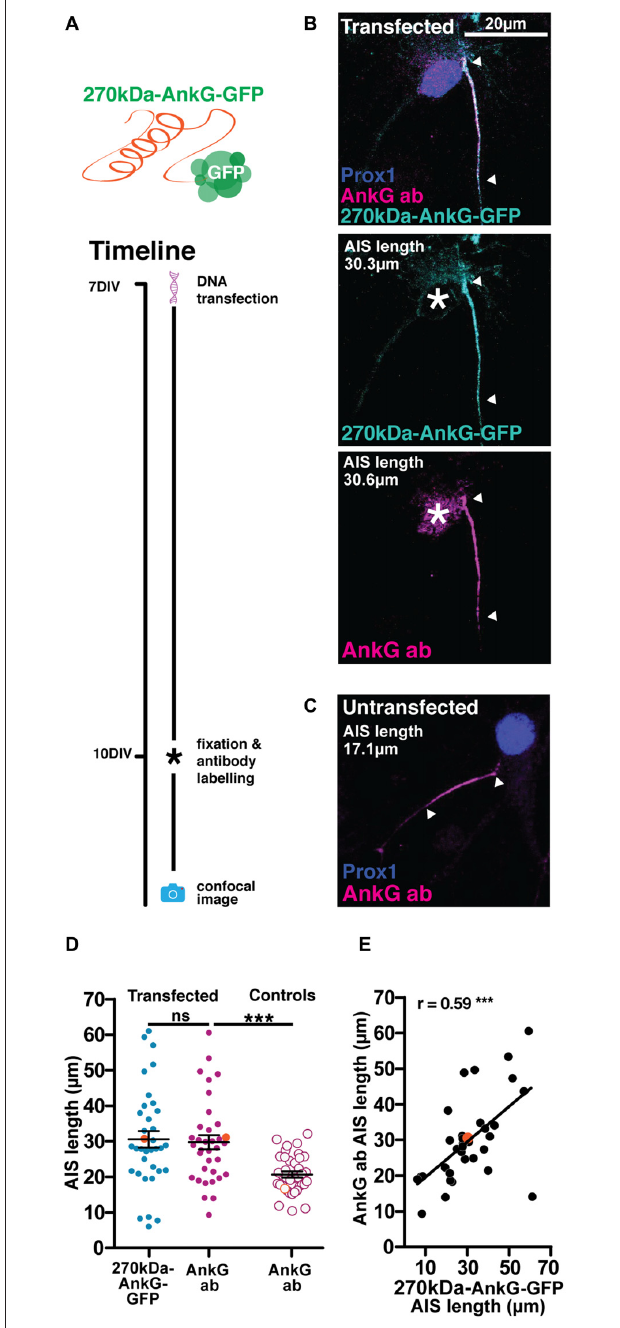
FIGURE 6 | The 270kDa-AnkG-GFP construct artificially increases AIS length in mature neurons. (A) Diagram of construct used and transfection method timeline. (B) Maximum intensity projection of a DGC expressing 270kDa-AnkG-GFP (cyan) which co-localizes with an anti-AnkG antibody (magenta). Asterisks, nucleus; arrowheads, DGC AIS start and end positions. (C) Maximum intensity projection of an untransfected DGC bearing an AIS of normal length. Arrowheads DGC AIS start and end positions. (D) Distributions of AIS lengths measured from 270kDa-AnkG-GFP transfected neurons and control untransfected DGCs. Each dot or triangle represents a single cell; orange symbols represent cells from panel (B) ; dark lines show mean ±